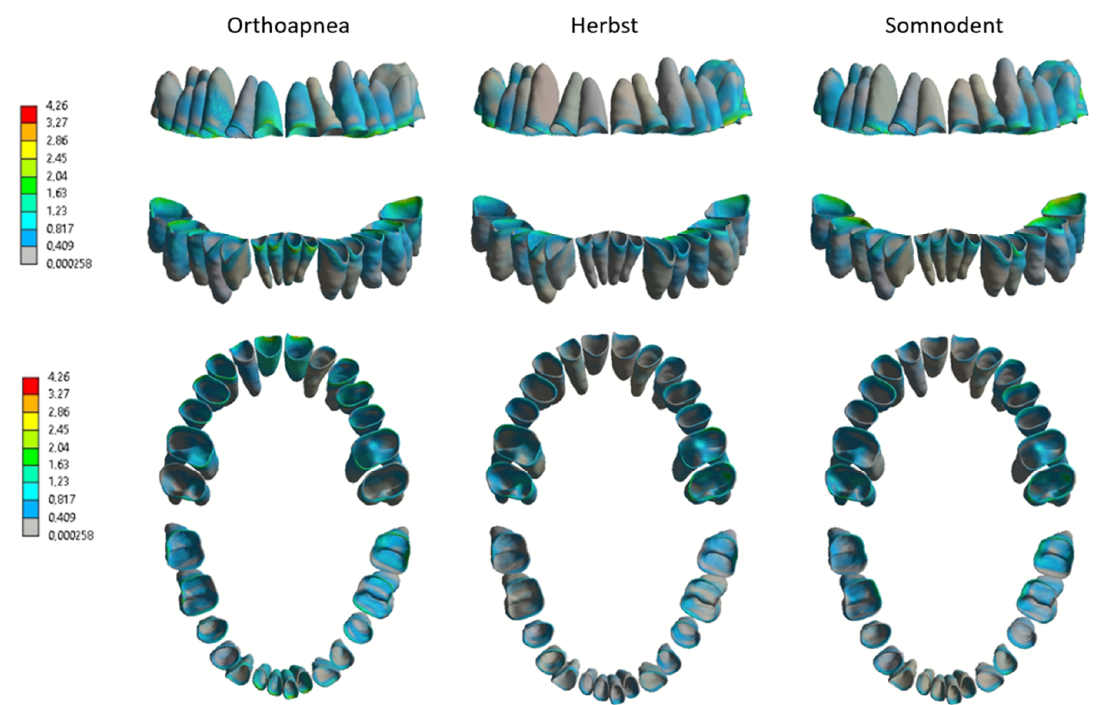
Figure 3. Contour plots. Periodontal ligaments (PDLs) stress distribution (kPa), frontal and occlusal view.